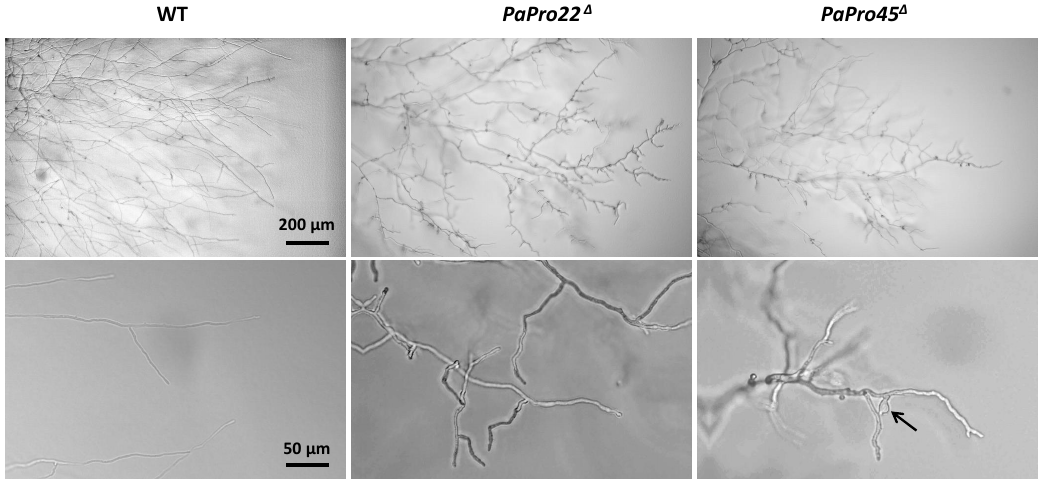
Figure 10. Morphology of WT and STRIPAK mutant hyphae. Pictures were taken with objectives × 10 ( top ) and × 40 ( bottom ). Arrow points towards inflated